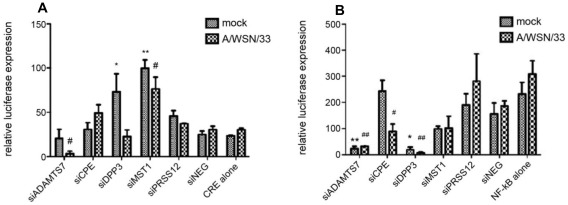
Analysis of host gene involvement in major cellular pathways.A: A549 cells were reverse cotransfected with CRE/CREB reporter plasmid or the appropriate control plasmid and 100 nM of the novel siRNA. After 24 h incubation, the transfection media was replaced with culture media. Cells were mock infected or infected with A/WSN/33 at an MOI of 0.001 the following day. After 24 h, culture supernatant was analyzed for luciferase expression. Luciferase units were normalized to Renilla expression. * p<0.05, ** p<0.01 compared to siNEG control (mock), # p<0.05, ## p<0.01 compared to siNEG control (A/WSN/33) B: A549 cells were reversed cotransfected with NF-κB reporter plasmid or the appropriate control plasmid and 100 nM of the novel siRNA. After 24 h incubation, the transfection media was replaced with culture media. Cells were mock infected or infected with A/WSN/33 at an MOI of 0.001 the following day. After 24 h, culture supernatant was analyzed for luciferase expression. Luciferase units were normalized to Renilla expression. * p<0.05, ** p<0.01 compared to siNEG control (mock), # p<0.05, ## p<0.01 compared to siNEG control (A/WSN/33). Data is representative of three independent experiments.